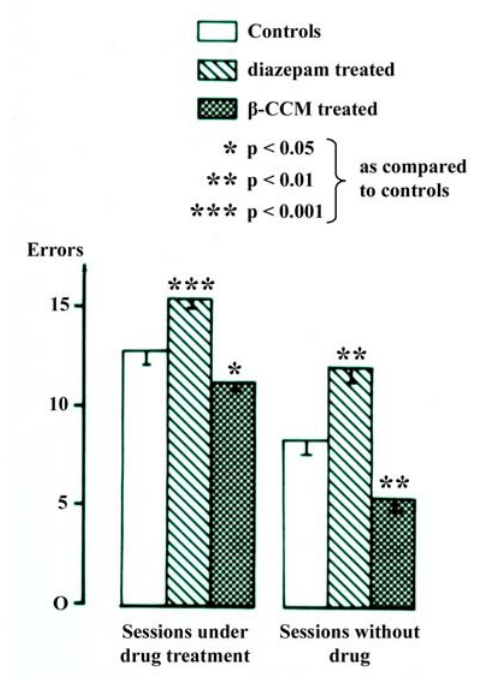
FIGURE 7. Results obtained in the T-maze after administration of diazepam and beta-CCM . For the first three sessions (30 trials), one group of mice received diazepam (2.5 mg/kg, i.p . ) and one group received beta-CCM (0.3 mg/kg, i.p . ); the three last sessions were performed without any drugs being administered. The results are presented for both groups and both situations (with and without drugs), and are compared to nontreated controls; they showed an increase in the number of errors by diazepam-treated animals and a decrease in the number of errors by beta-CCM–treated animals, suggesting that diazepam has an impairing action on learning and that beta-CCM has an enhancing action on learning. (Adapted from Raffalli-Sébille et